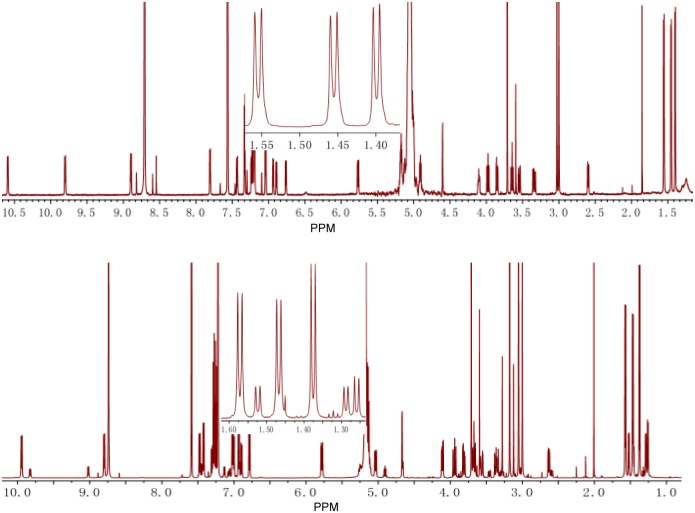

1H NMR spectra comparison of rubipodanin A (1, top) and RA-V (4, bottom).